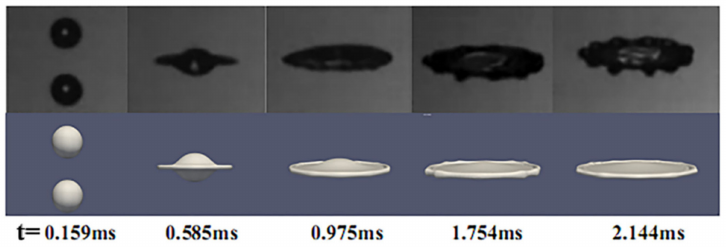
Figure 3. Experiments and numerical simulation results of binary equal-sized droplets collision with We = 210: Experimental result of Pan et al. (2009) [21] (above). Simulation result (below).